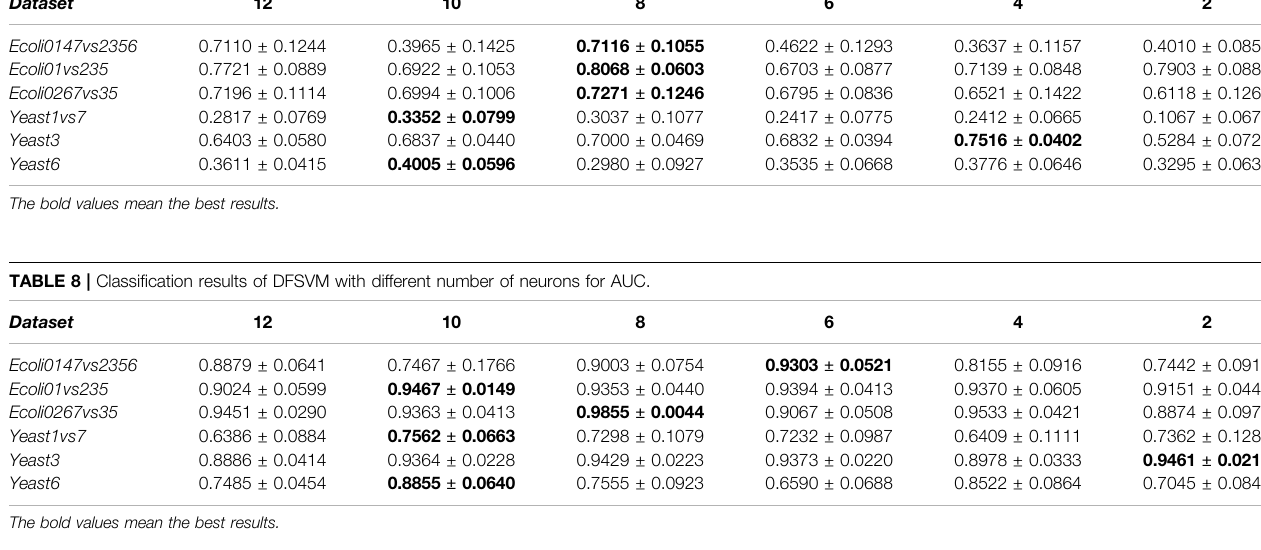
TABLE 7 | Classi fi cation results of DFSVM with different number of neurons for F-measure.